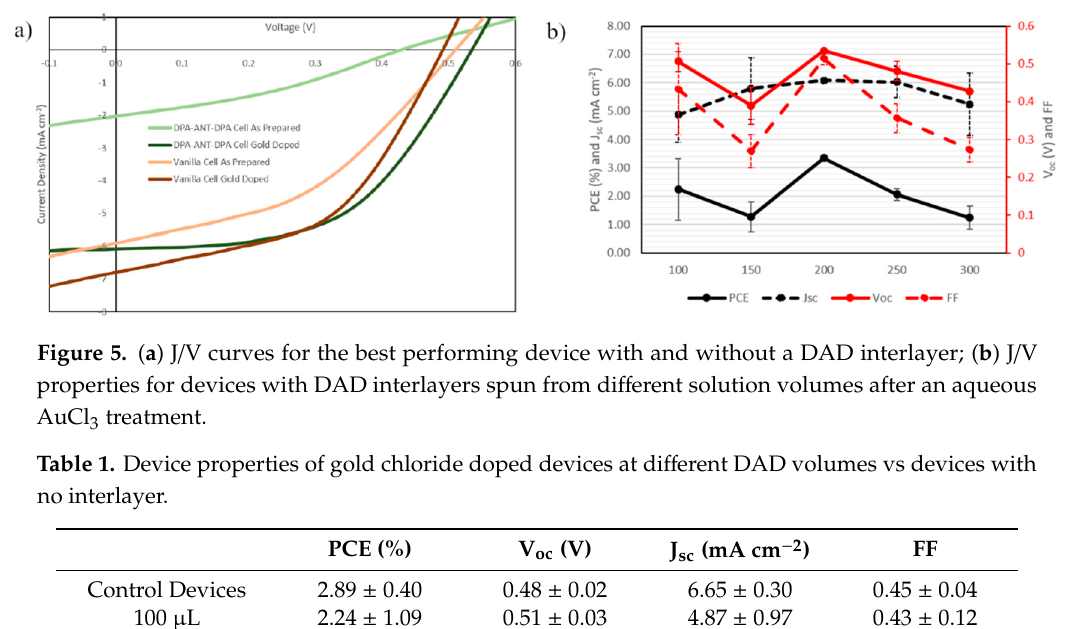
Figure 4. ( a ) Atomic force microscopy (AFM) height maps of DAD films spun from different solution volumes. A spin speed of 5000 rpm was used for all films; ( b ) representative AFM cross sectional line graphs (each cross section is off set for clarity), and percentage height distribution plots of DAD films spun from a 300 µL volume at 5000 rpm.